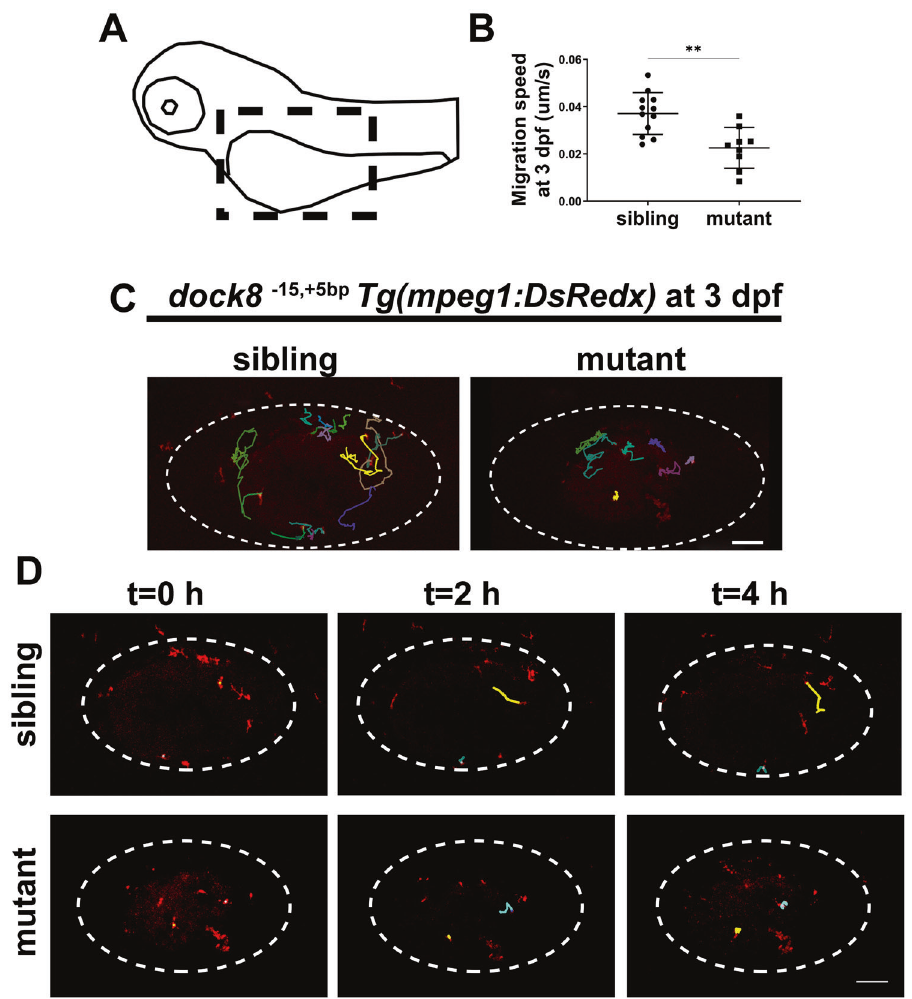
Fig. 4 dock8 de fi ciency affects migration speed of macrophages in zebra fi sh larvae. A Schematic diagram of the imaging region. Black dash lines represent the imaging area. B Quanti fi cation of migration speed of mpeg1 + cells in dock8 -15, + 5bp mutants and siblings yolk sac within 4 h from 3 dpf, each dot represents one larva. C Representative images of mpeg1 + cells tracking in dock8 -15, + 5bp mutants and siblings yolk sac at 3 dpf. Each line represents the migration path of one macrophage. D Time-lapse confocal imaging of Tg(mpeg1:DsRed);dock8 15, + 5bp embryos from 3 dpf within 4 h. Each line represents the migration path of one macrophage. White dotted lines indicate the yolk sac. Scale bar = 100 µm. See also Video S 1. Data were analyzed by unpaired Student ’ s t -tests. ** P ≤ 0.01